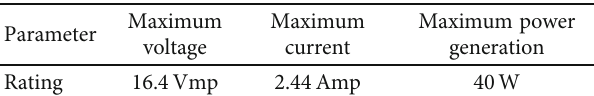
Table 5: Rating of the PV